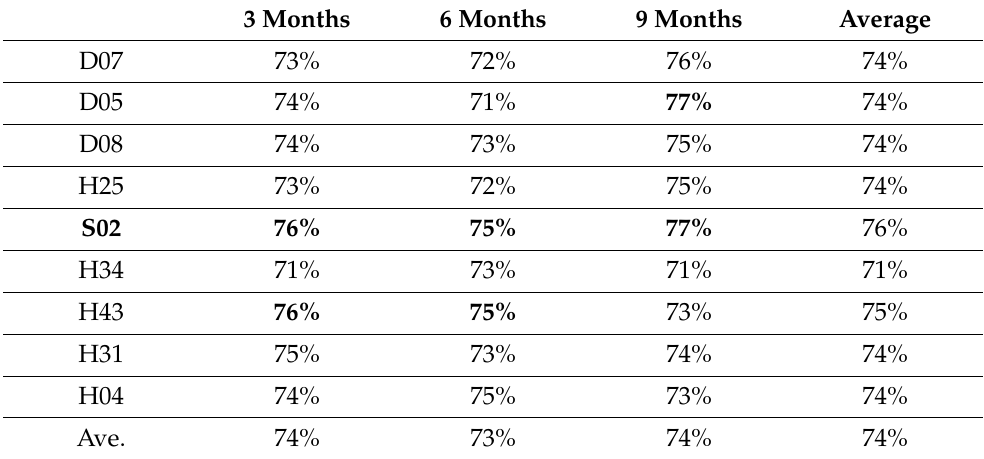
Table 5. Simulation experiment result: planned maintenance to each equipment (duration: 18